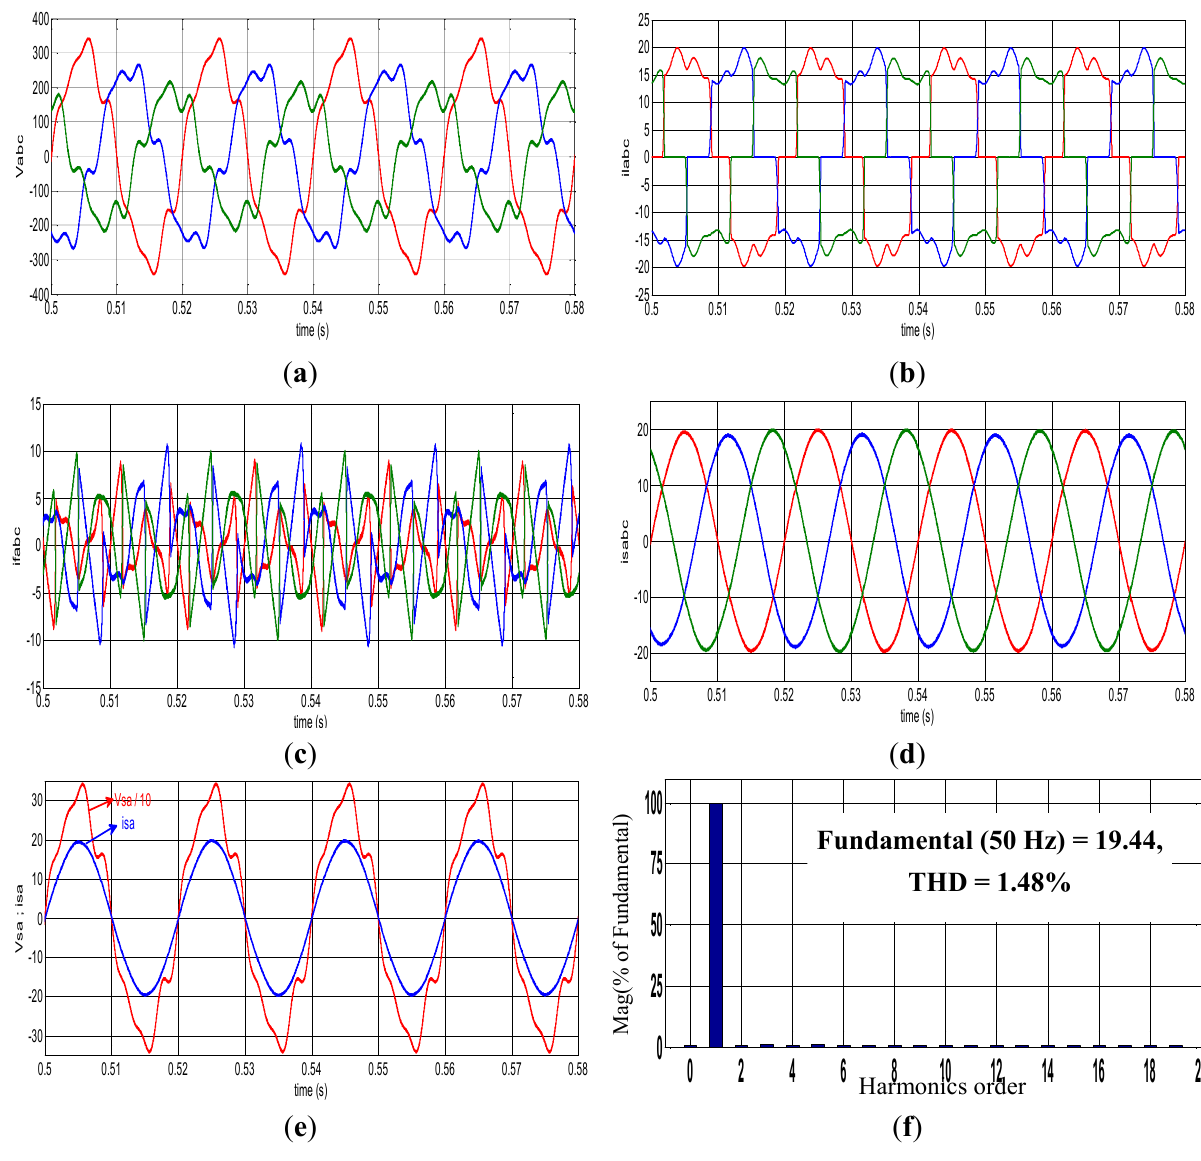
Figure 15. simulation results of unbalanced distorted grid voltage: ( a ) three-phase line voltages; ( b ) three-phase load currents; ( c ) three-phase filter currents; ( d ) three-phase line currents; ( e ) line voltage and current, phase-a; ( f ) frequency spectrum of line current,